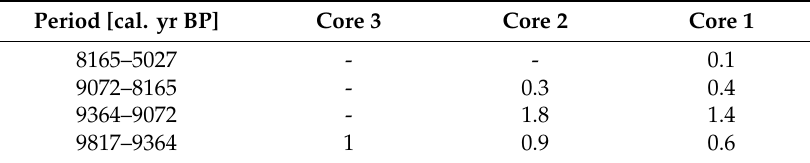
Table 5. Sedimentation rate meter per century for selected periods.